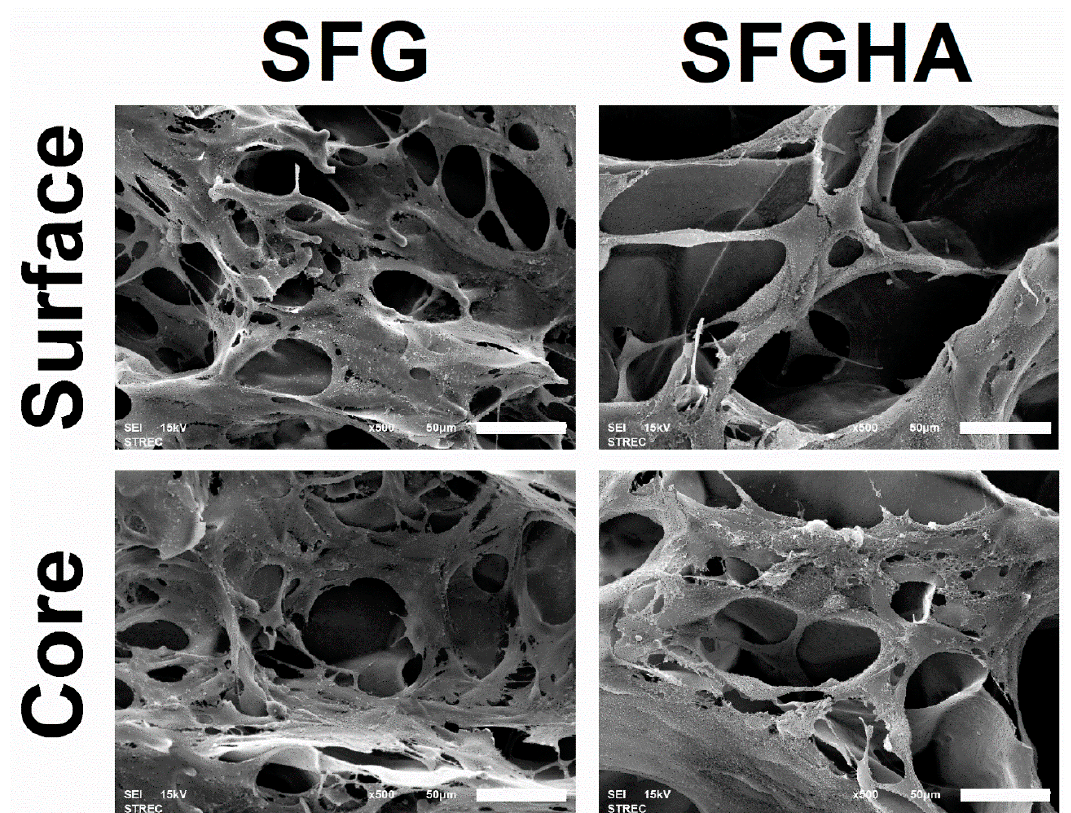
Figure 5. SEM micrographs of cell-loaded SFG and SFGHA scaffolds obtained at 5-day post-seeding. The images of outer surface and inner core are presented. Scale bar = 50 µm.